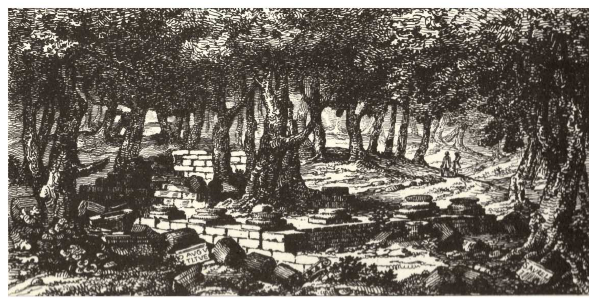
Figure 3. The ruins of the temple of Antas seen by Alberto della Marmora in the nineteenth century (della Marmora, 1840) .